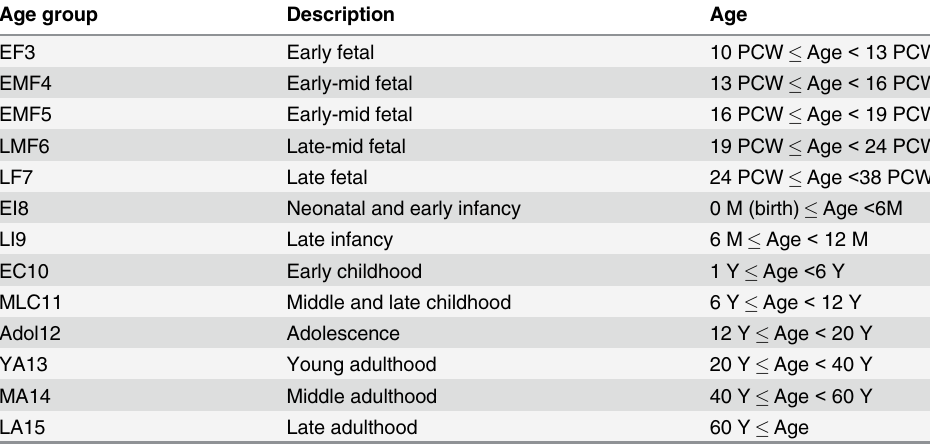
Table 1. Donors age groups following [32].